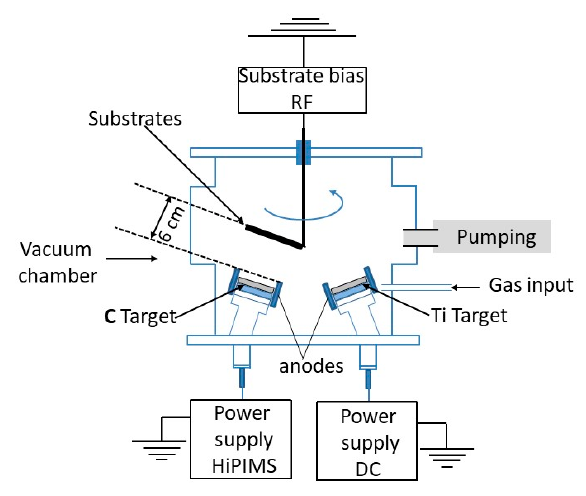
Figure 1. Experimental Setup.